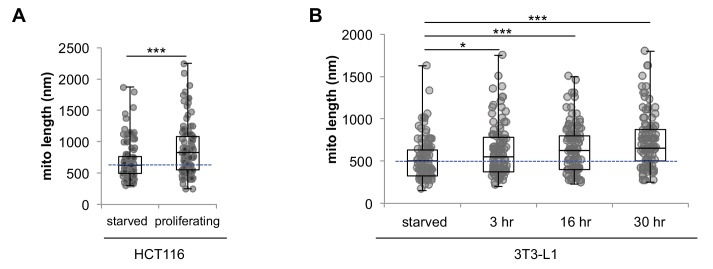
Serum starvation induces mitochondrial fragmentation in 3T3-L1 and HCT116 cells.Mitochondrial elongation starts as soon as 3 hr after addition of serum. (A) Statistical analysis of mitochondrial length in serum starved HCT116 cells and proliferating HCT116 cells cultured in normal media. (B) Statistical analysis of mitochondrial length in serum starved quiescent 3T3-L1 fibroblasts. After serum was added to the media, mitochondrial length increased in as quick as 3 hr. For each condition, 100 random mitochondria were measured from EM images. Data are presented as mean ±SD.